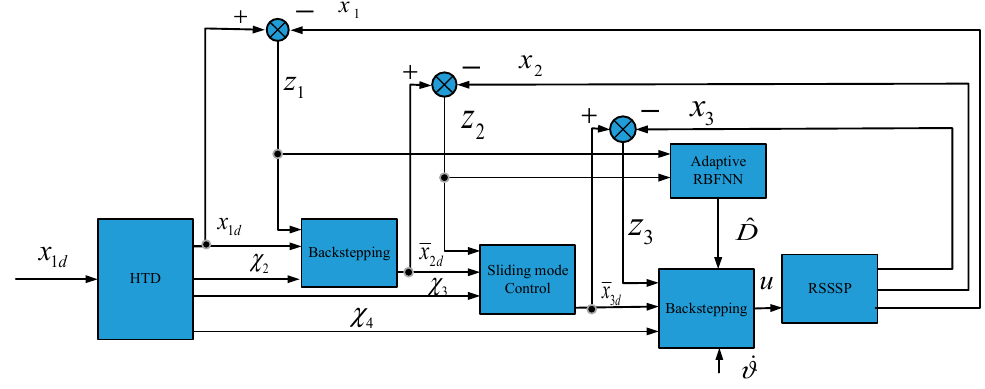
Figure 6. Control block diagram of proposed method.